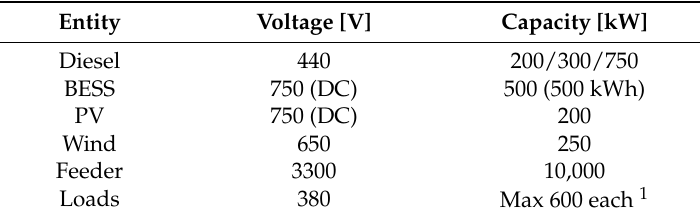
Figure 3. Microgrid model layout. Table 1. Microgrid components rating.